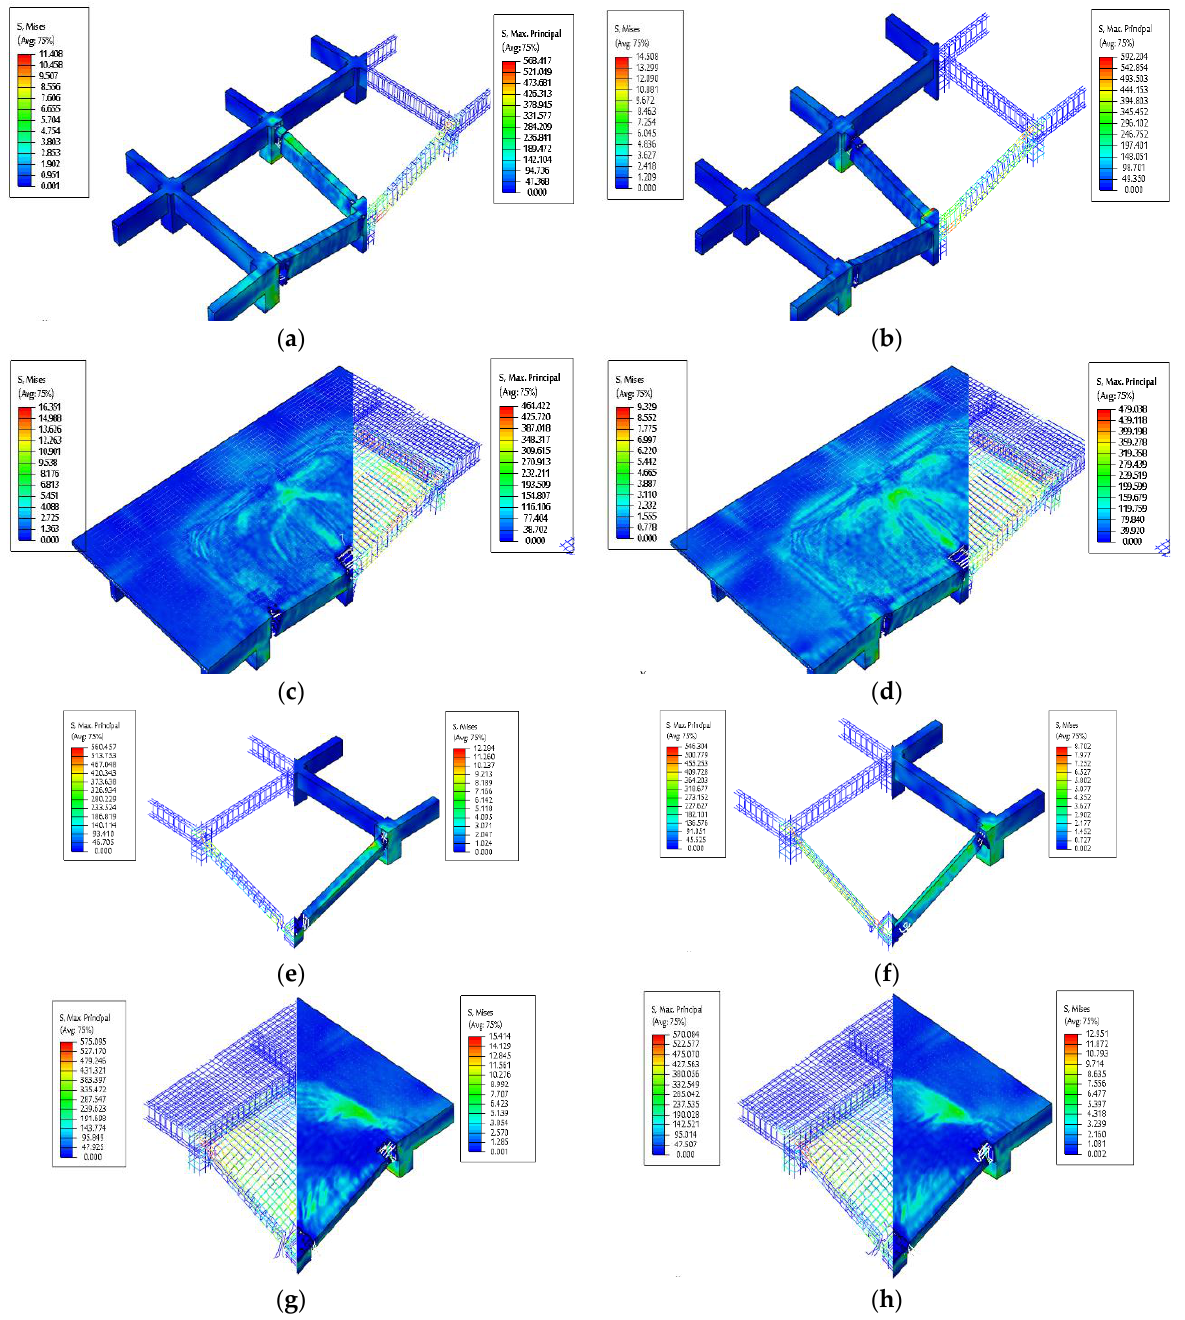
Figure 19. Failure mode and crack pattern for all specimens: ( a ) NC-MID; ( b ) RuC-MID; ( c ) NC-MID-Slab; ( d ) RuC-MID-Slab; ( e ) NC-COR; ( f ) RuC-COR; ( g ) NC-COR-Slab; and ( h ) RuC-COR-Slab.